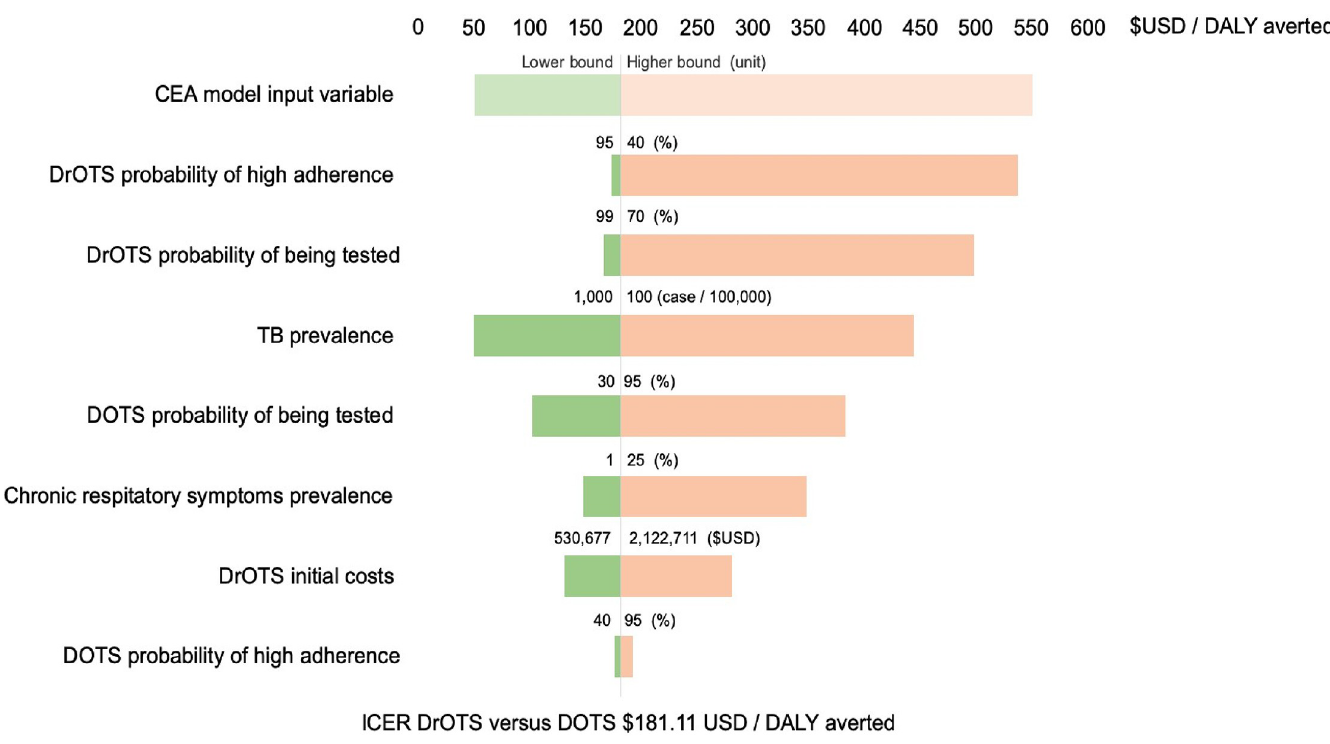
Fig 3. Incremental cost-effectiveness ratio of DrOTS over DOTS–sensitivity analysis. Sensitivity analysis around key input variables of DrOTS versus DOTS incremental cost effectiveness ratio analysis.